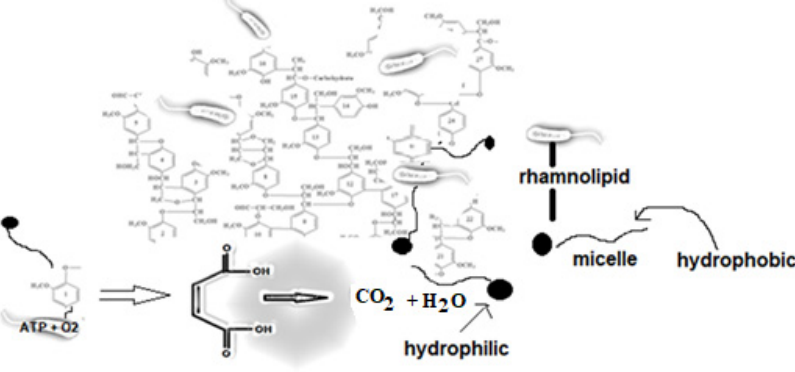
Figure 9. Theoretical approach degradation of phenolic compounds by the native bacteria